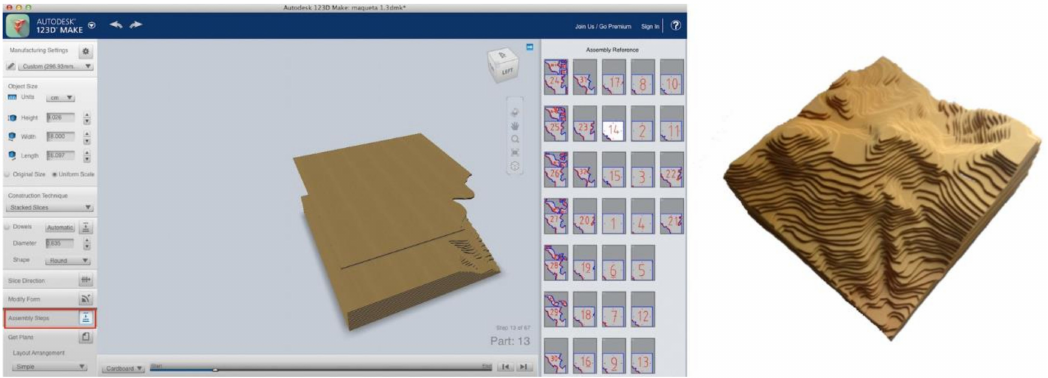
Figure 3. ( Left ) Autodesk123 Make interface screen capture. ( Right ) 3D model created by